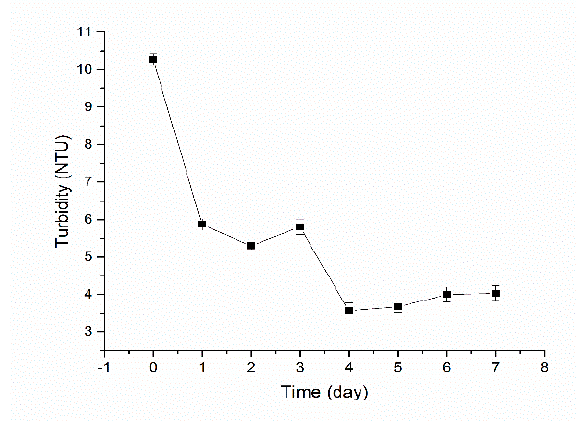
Figure 5. Removal of turbidity.